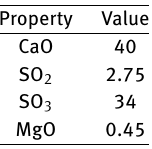
Table 2: Chemical composition of desulfurized gypsum (%)